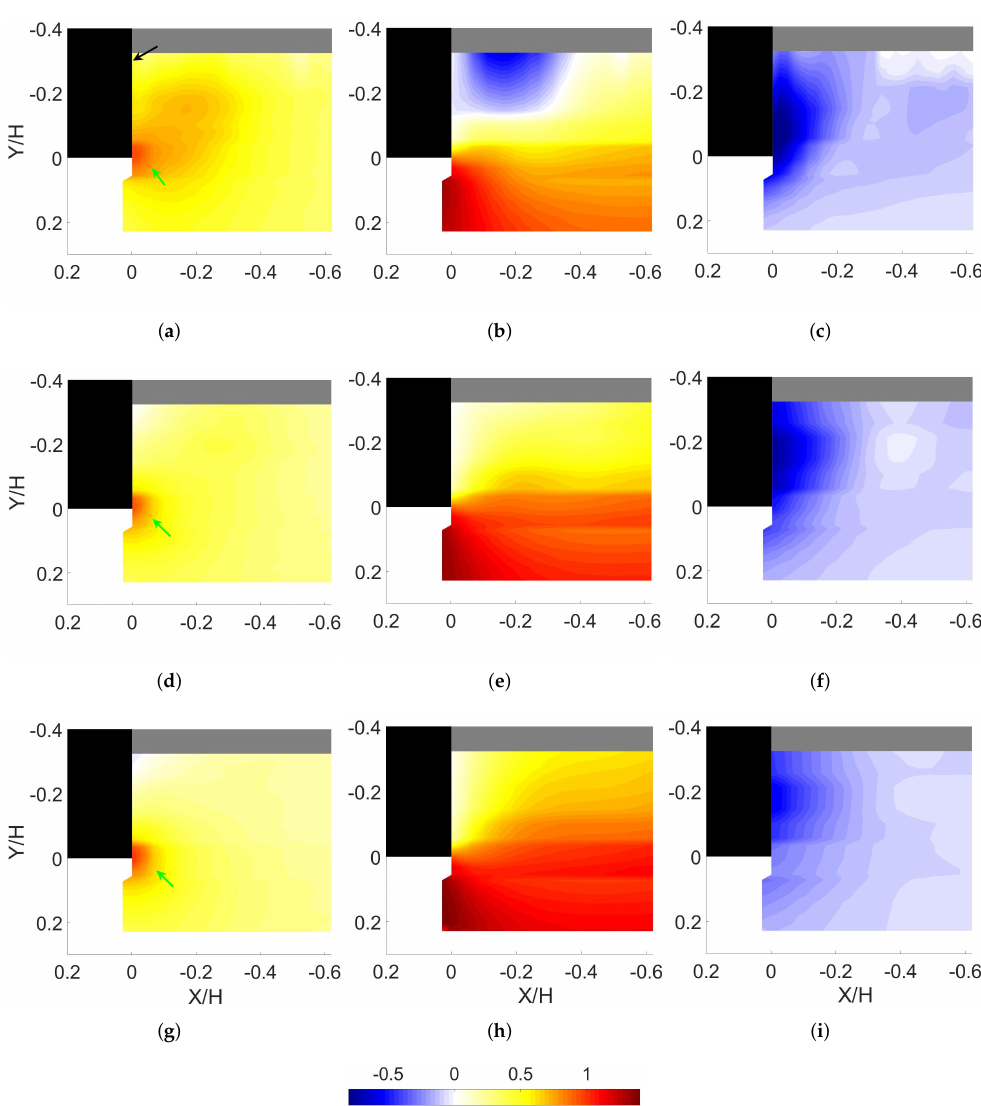
= 0.18, ( d – f ) Z = 0.32, and H H